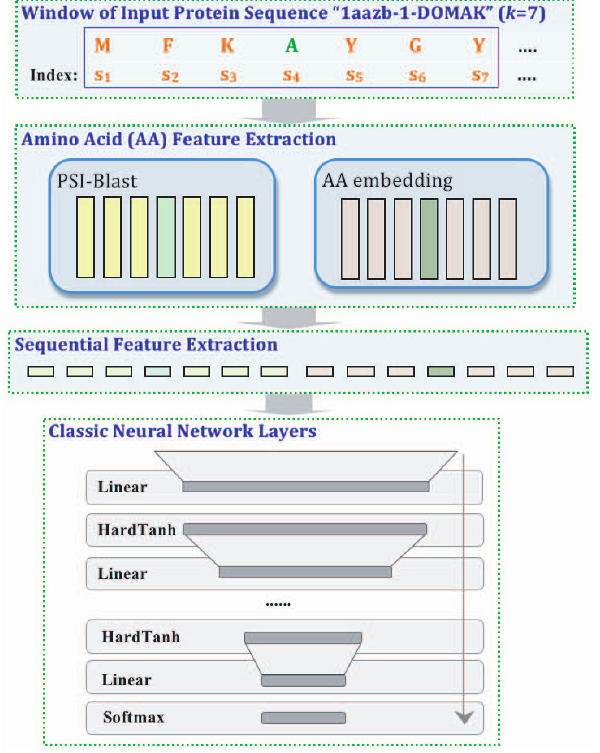
Figure 1. Deep neural network architecture. Given an input amino acid sequence, the neural network outputs a posterior distribution over the class labels for that amino acid. This general deep network architecture is suitable for all of our prediction tasks. The network is characterized by three parts: (1) an amino acid feature extraction layer, (2) a sequential feature extraction layer, and (3) a series of classical neural network layers. The first layer consists a PSI-BLAST feature module and an amino acid embedding module. With a sliding window input f s 1 , s 2 , ... s k g (here k ~ 7 ), the amino acid embedding module outputs a series of real valued vectors f W s , W s , ... W s g . Similarly, the 1 2 k PSI-BLAST module derives k 20-dimensional PSI-BLAST feature vectors corresponding to the k amino acids. These vectors are then concatenated in the sequential extraction layer of the network. Finally, the derived vector is fed into the classical neural network layers. The final softmax layer allows us to interpret the outputs as probabilities for each